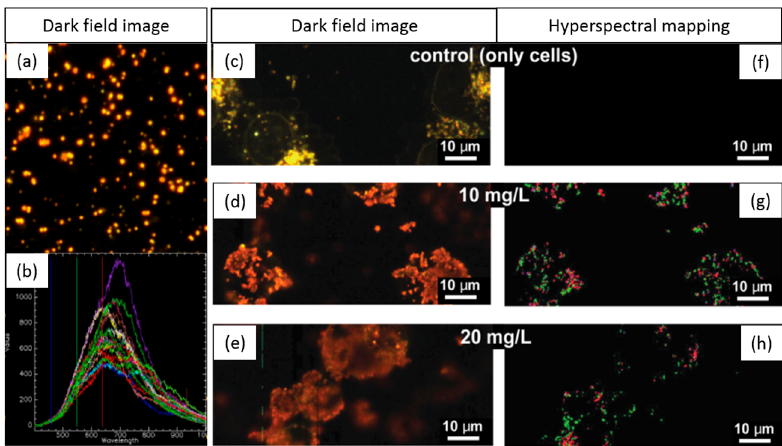
Figure 9. Mapping of hybrid nanostructures in human breast cancer cells to determine the optimal particle concentration for photothermal therapy. ( a ) Dark field image of the NPs; ( b ) spectral library endmembers; ( c – e ) dark field image of control cells and cells exposed to 10 and 20 mg/L NP concentrations; ( f – h ) hyperspectral imaging of the spectral library demonstrating the presence of the particles in the cells (false-colored image) [21].